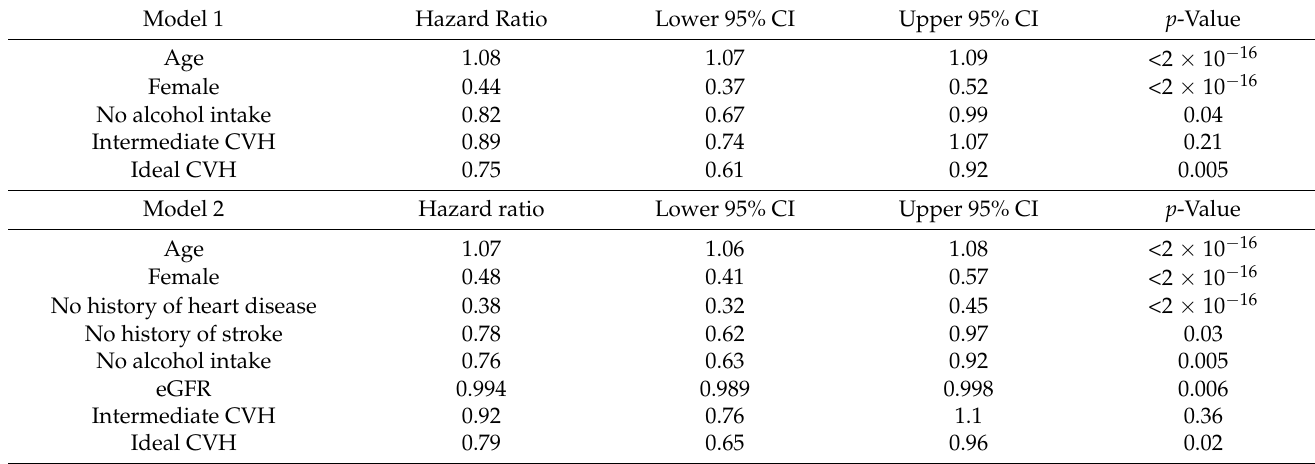
Table 2. Association between cardiovascular health (CVH) score and incident atrial fibrillation in all participants. Model 1 was adjusted for age, gender, and regular alcohol intake. Model 2 was adjusted for age, gender, history of heart disease, history of stroke, regular alcohol intake, and estimated glomerular filtration rate (eGFR). The hazard ratio of the intermediate and ideal CVH groups was calculated using the poor CVH group as a